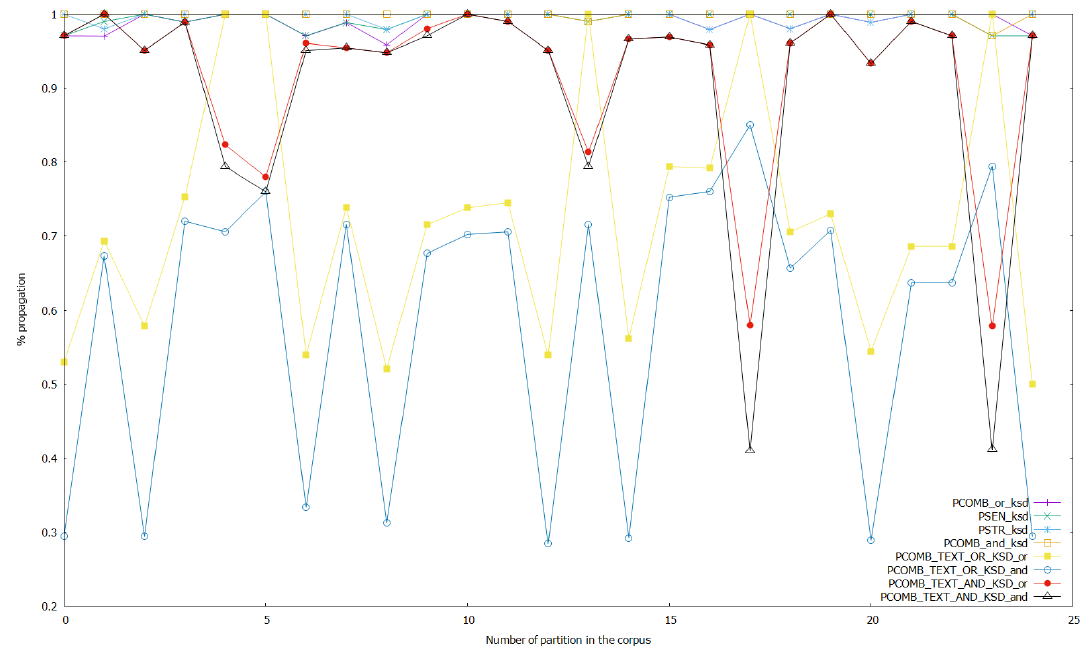
Figure 7. Results of the experiments with the sentiment, stress, and combined analyses on keystroke data, and with the combined analyses on text and keystroke data with threshold set to 0.7 in the ANNs that work with keystroke